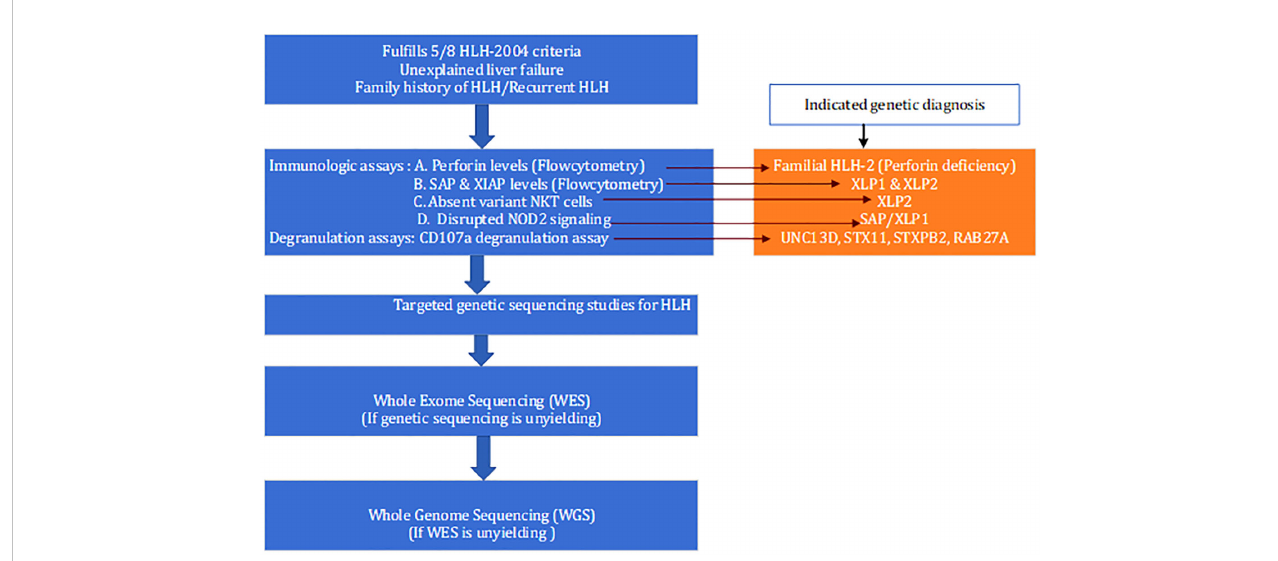
FIGURE 3 Proposed diagnostic algorithm for the diagnosis of suspected primary